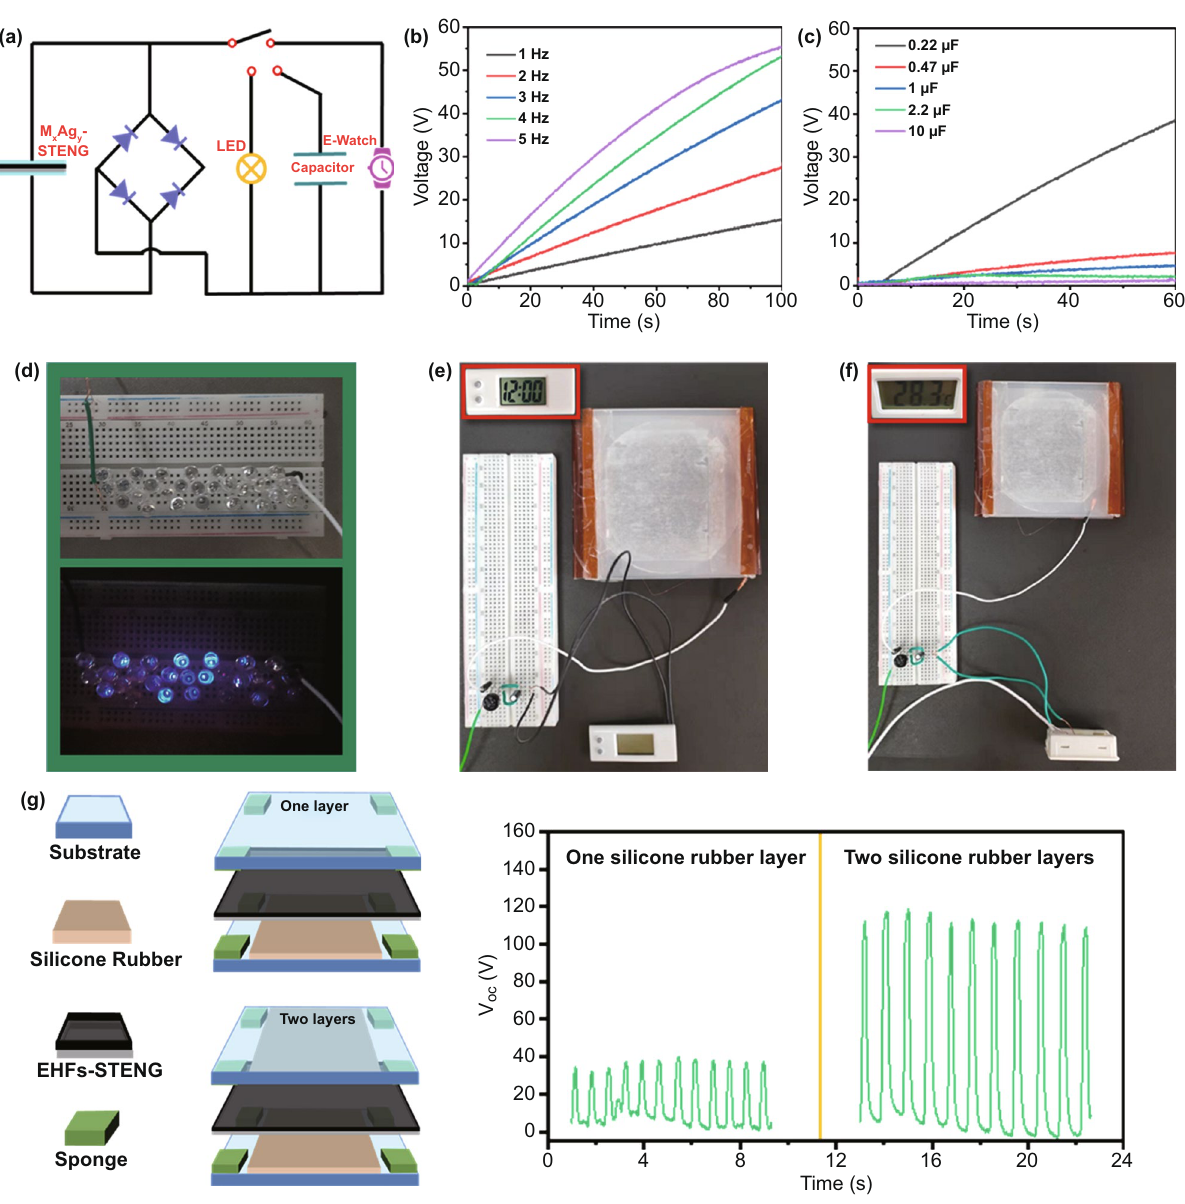
Fig. 4 a Self-charging power supply system based on the equivalent circuit diagram. The charging ability of the EHFs-based STENG b with various frequencies (1–5 Hz) for charging a 0.22 µF commercial capacitor and c charging different capacitors (0.22–10 µF) at a frequency of 5 Hz. The electricity output from the STENG can drive d LEDs to shine, e electronic watches to run, and f electronic thermometers to work. g V OC of the EHFs-based STENG under single and double triboelectrification